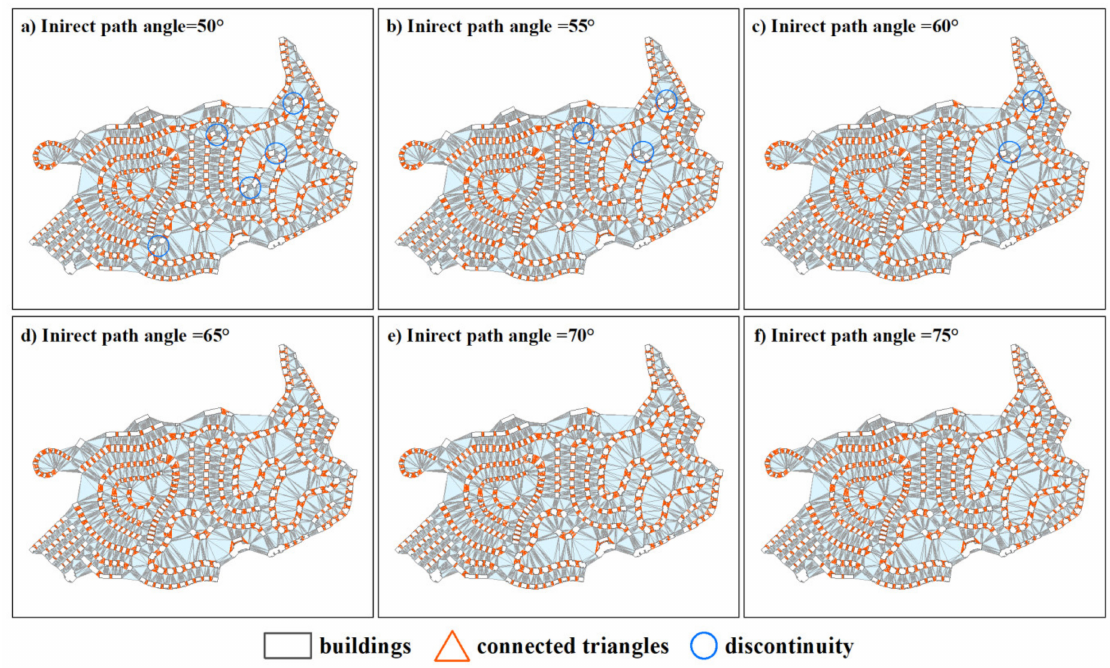
Figure 12. Linear pattern recognition results of the proposed method with di ff erent indirect path angle values and direct path angles of 100 ◦ in the SZ dataset. Buildings connected with orange edge triangles are recognized as linear building